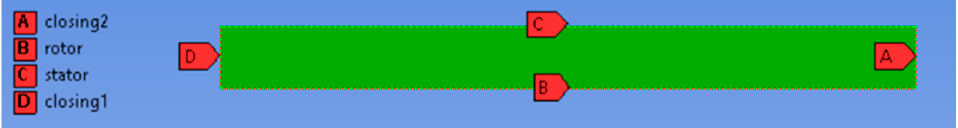
Figure 6. Reynolds number vs. speed for oil, ethanol, water and EMG 900 (Re c = 1100 to 1300).